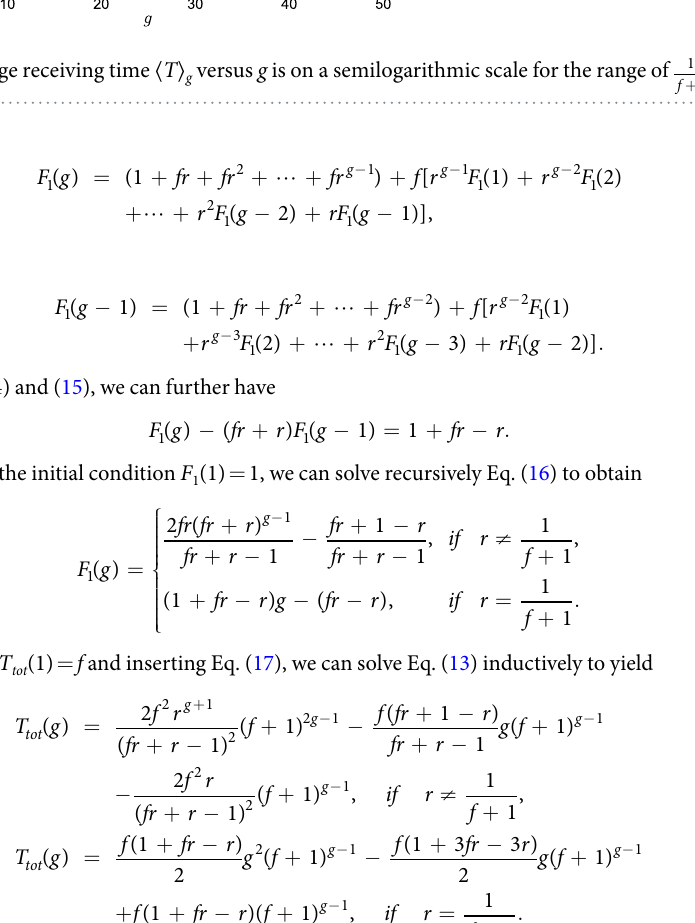
Figure 5. Average receiving time 〈 T 〉 g versus g is on a semilogarithmic scale for the range of < ≤